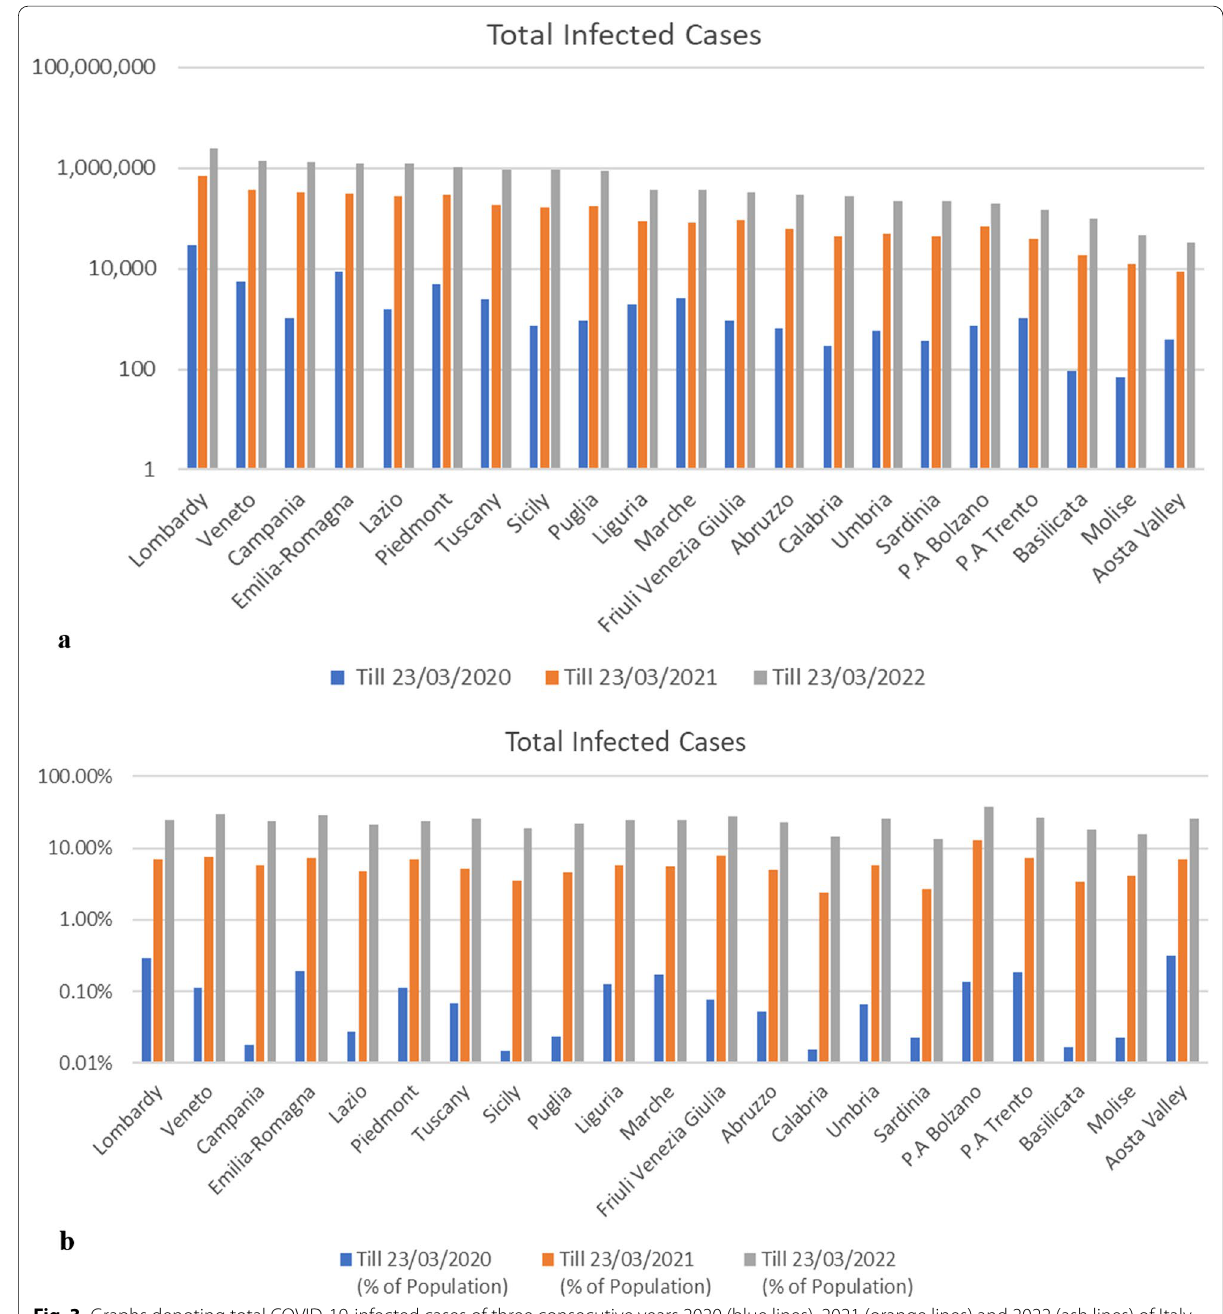
Fig. 3 Graphs denoting total COVID-19-infected cases of three consecutive years 2020 (blue lines), 2021 (orange lines) and 2022 (ash lines) of Italy. Data have explained from the first day of viral propagation to 23 March 2020 to 23 March 2021 to the current year of 23 March. Total infected cases are obtained by both molecular swab and rapid antigenic swab tests which is 140,70,450 confirmed positive cases to date. The scheme ( a ) depicts the overall total cases in 20 regions based on the exact number of persons infected by SARS-CoV2. In ( b ) total infected cases have been explained in accordance with total population of each region (% of